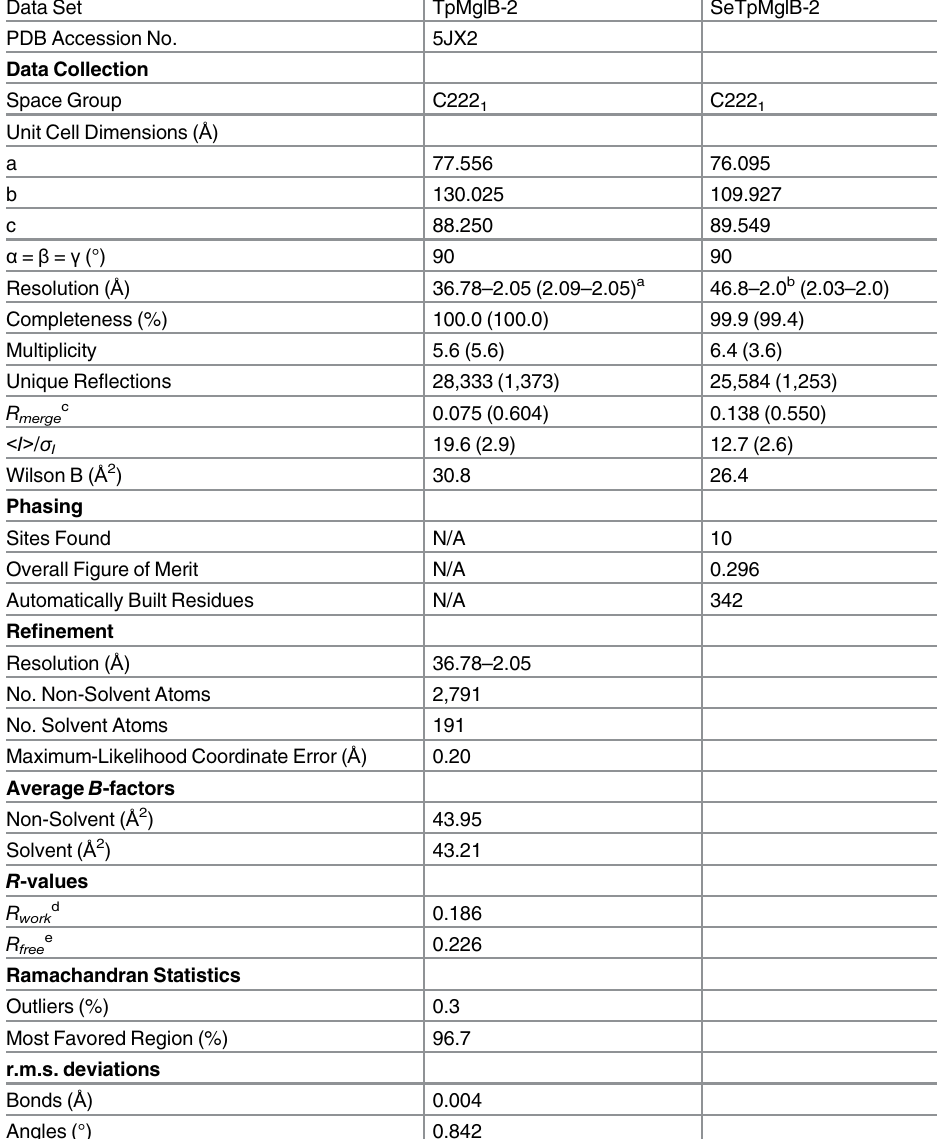
Table 1. Data collection, phasing, and refinement